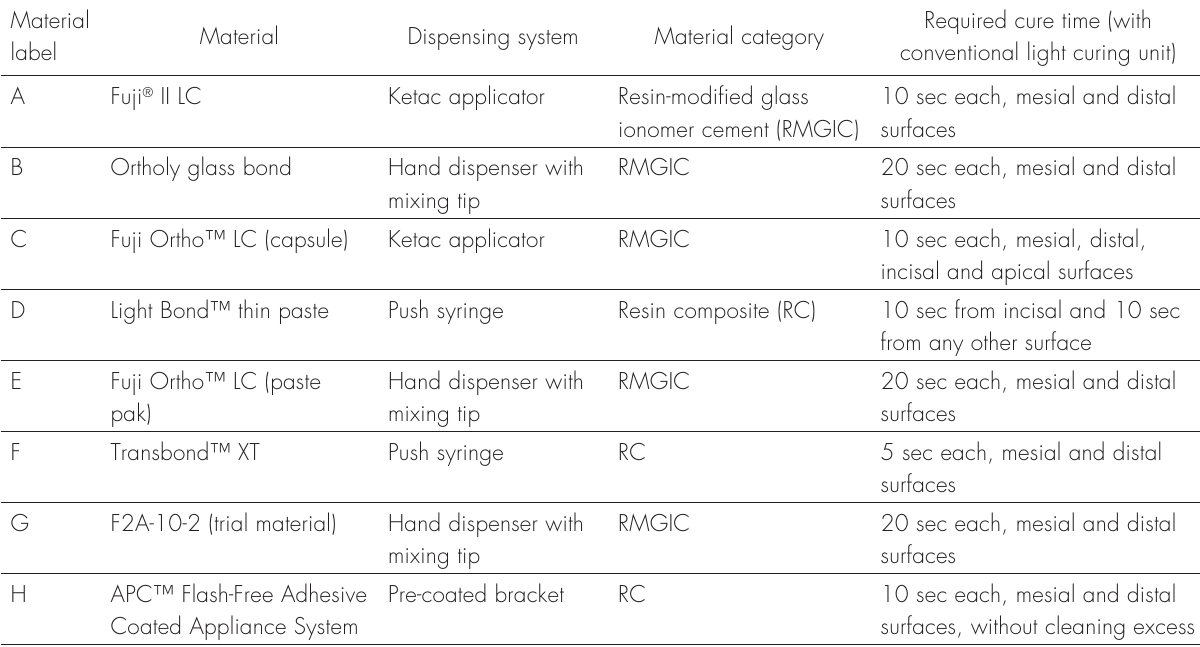
Table I. Materials trialled in the study and corresponding labels, dispensing system of each material, material category, manufacturers’ instructions for material cure times with conventional light curing units. Material